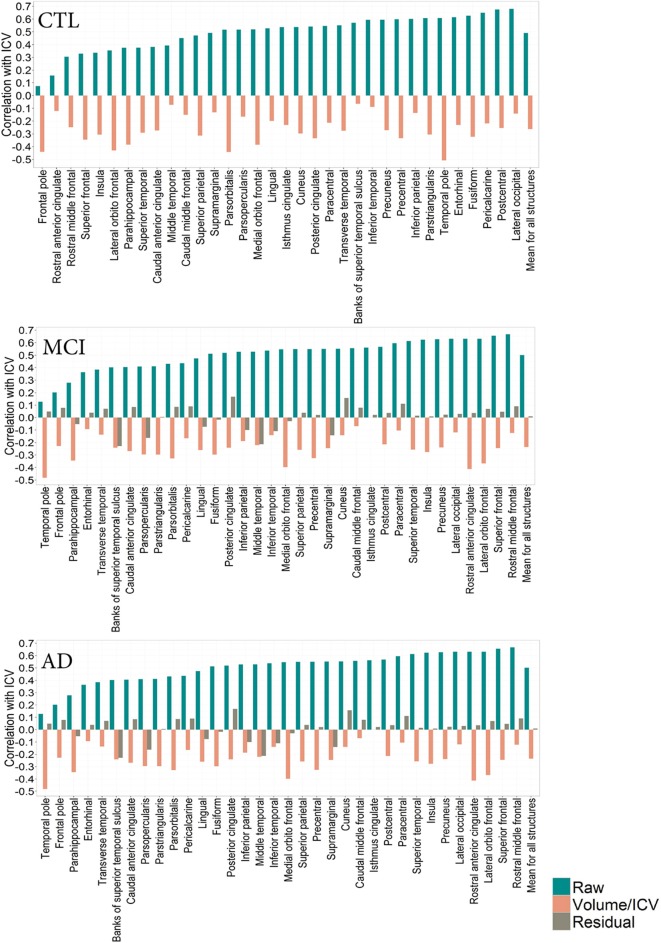
CTL: Correlation patterns created for individual regional subcortical volumes in the CTL subset of the ADNI cohort using different normalization methods. Mean correlation coefficients: Rraw(CTL) = 0.49 (0.10), Rproportion(CTL) = −0.19 (0.30). MCI: Correlation patterns created for individual regional subcortical volumes in the MCI subset of the ADNI cohort using different normalization methods. Mean correlation coefficients: Rraw(MCI) = 0.49 (0.15)Rproportion(MCI) = −0.17 (0.26), Rresidual(MCI) = 0.02(0.10). AD: Correlation patterns created for individual regional subcortical volumes in the AD subset of the ADNI cohort using different normalization methods. Mean correlation coefficients:Rraw(AD) = 0.49 (0.15), Rproportion(AD) = −0.19 (0.27), Rresidual(AD) = 0.007(0.09).